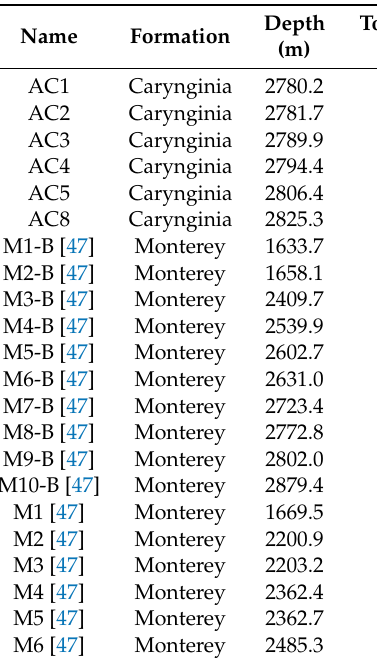
Table 1. XRD mineralogical composition for shales from Carynginia and Monterey formation. Some data were collected from the other